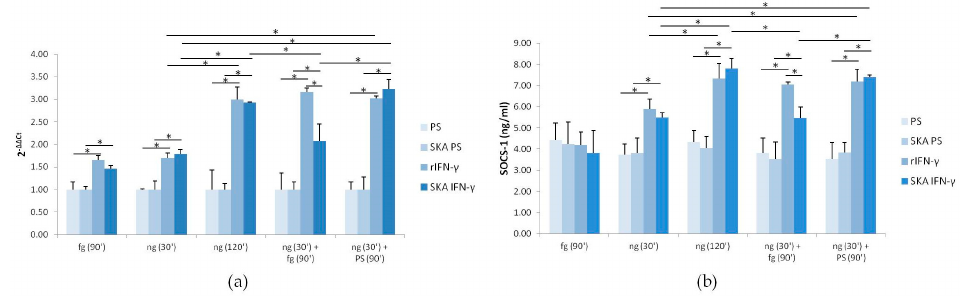
Figure 3. SOCS-1 in Jurkat cells in response to fg SKA IFN- γ . ( a ) Jurkat cells were treated as described